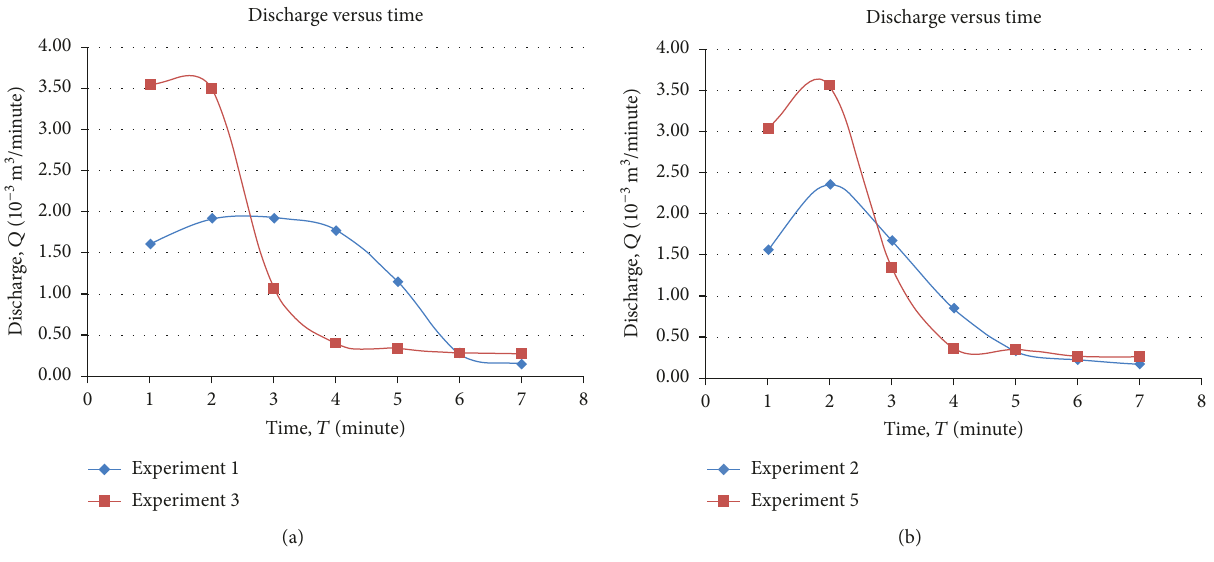
Figure 10: Comparison of discharge between (a) Experiments 1 and 3 and (b) Experiments 2 and 5 for the first 7